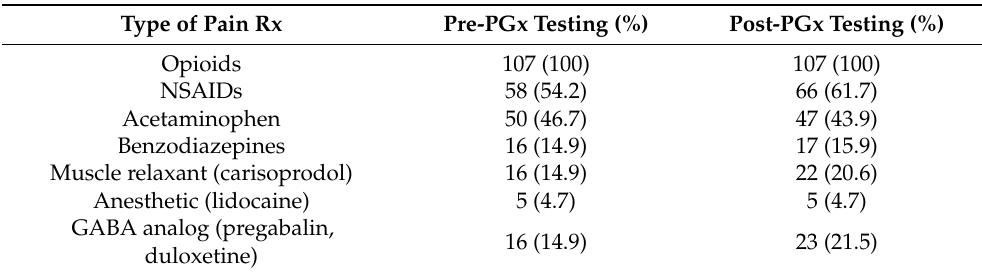
Table 2. Type of pain medications prescribed to patients pre- and post-pharmacogenomic (PGx) testing (N = 107).